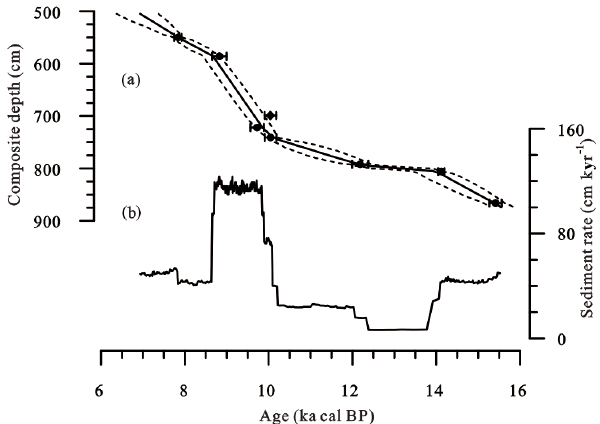
Figure 2. (a) Age–depth model for the Lake Chenghai sediment core produced using Bacon software (Blaauw and Andres Christen, 2011) from Sun et al. (2019). Dotted lines indicate the 95% confi- dence range and the solid line indicates the weighted mean ages for each depth; error bars indicate the standard deviation range (2 σ ) of the calibrated radiocarbon dates. (b) Estimated sedimentation rate (Sun et al.,